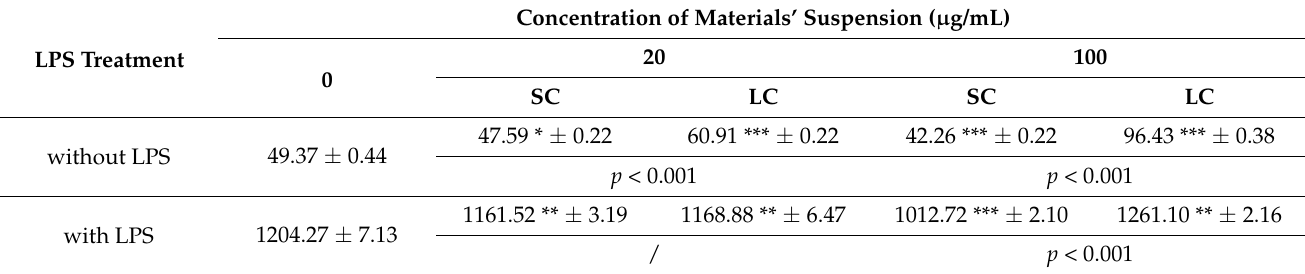
Table 2. Concentration of TNF- α (pg/mL) in macrophages’ cell culture media, measured by ELISA.